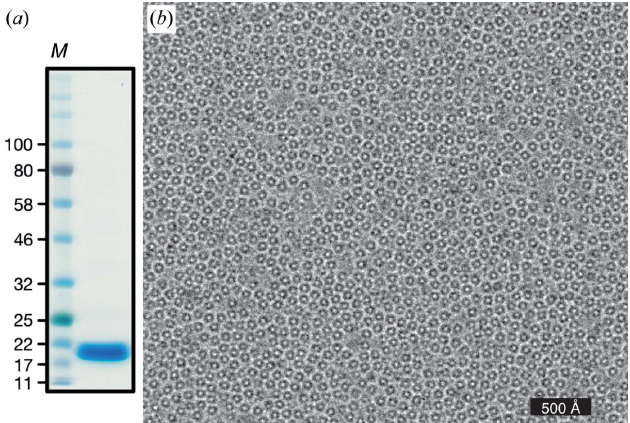
Figure 3 Purification of DPS from E. coli . ( a ) DPS is a homododecamer of 20 kDa peptides. The Coomassie-stained denaturing gel shows DPS as purified after ion-exchange chromatography. Lane M contains molecular-weight markers (labelled in kDa). ( b ) Representative micrograph (100 kV, cropped from full frame) of DPS particles in unsupported vitreous